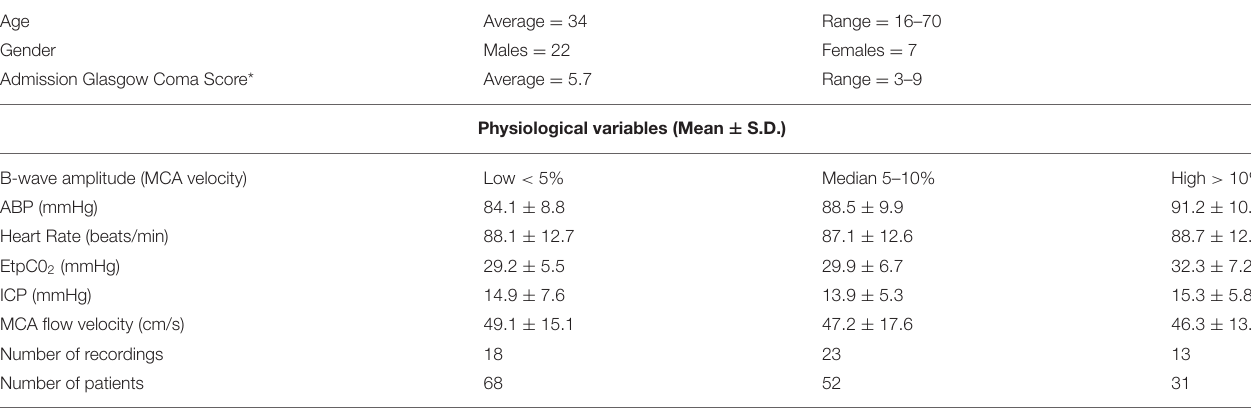
TABLE 1 | Overall patient characteristics ( n = 29) and physiological data.